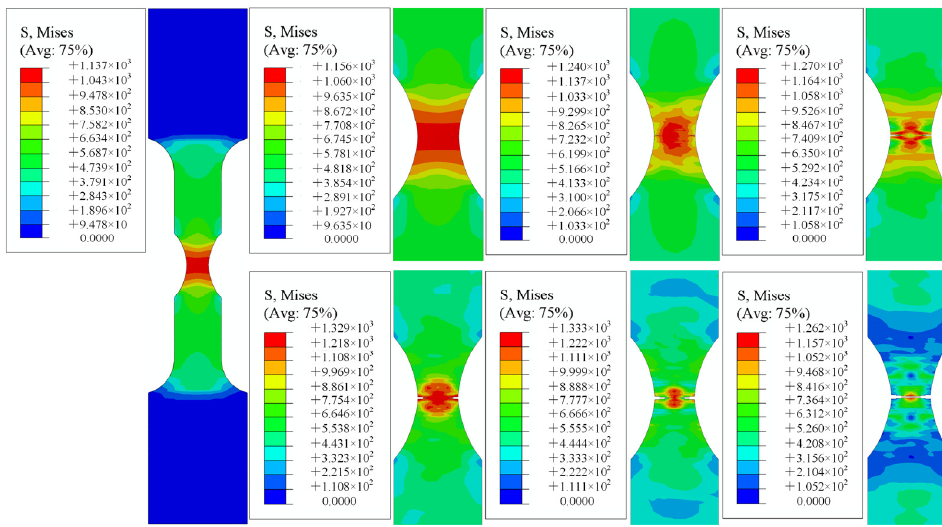
Figure 16. Notch specimen 2 (R = 5 mm).